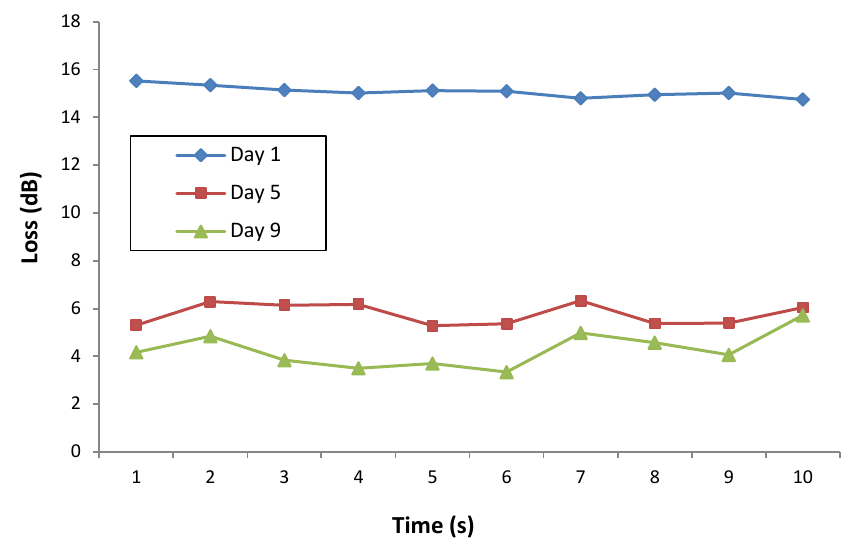
Figure 6. Power loss (dB) against time for selected samples for the WJSC.SC3 cell line (samples taken from Day 1, Day 5 and Day 9).